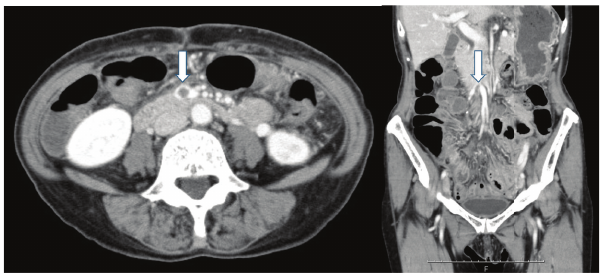
Figure1:Contrastenhancedcomputedtomographicscan(axialand coronal views) of the abdomen demonstrated a filling defect in the superior mesenteric vein (arrow), suggesting thrombus.